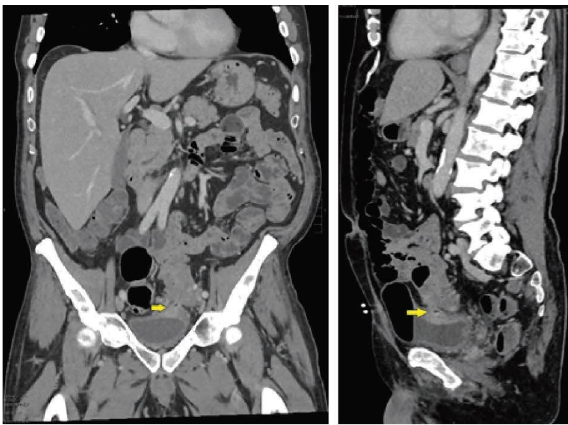
Figure 1: Sagittal and coronal CT imaging of colovesical fstula extending from the sigmoid colon to the left mid bladder.